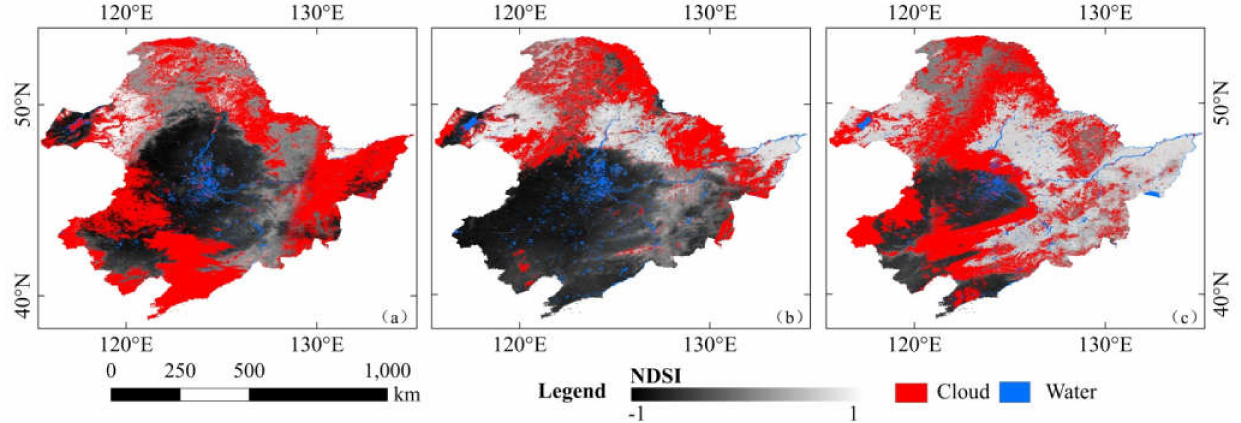
Figure 9. Cloud mask MOD10A1 in the NDSI_Snow_Cover data layer. ( a ) 12 February, 2019, ( b ) 22 March, 2018, and ( c ) 16 March, 2018.